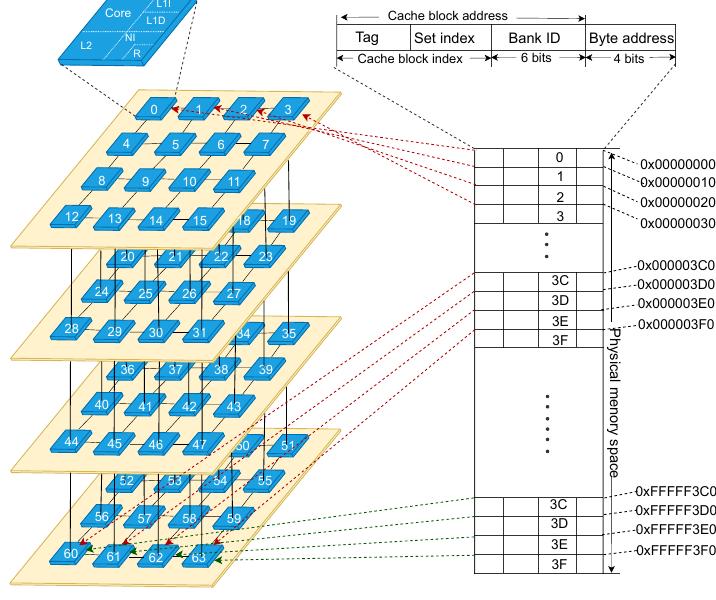
Figure 2. Baseline